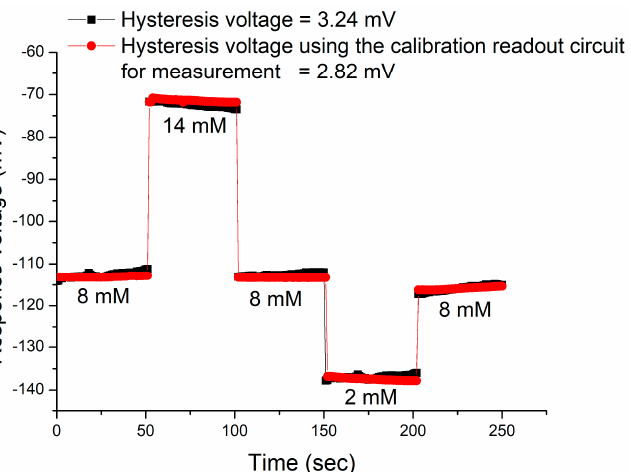
Figure 13. Hysteresis voltages of the CZO sensor by using the V-T measurement system and calibration readout circuit in the reverse cycle.